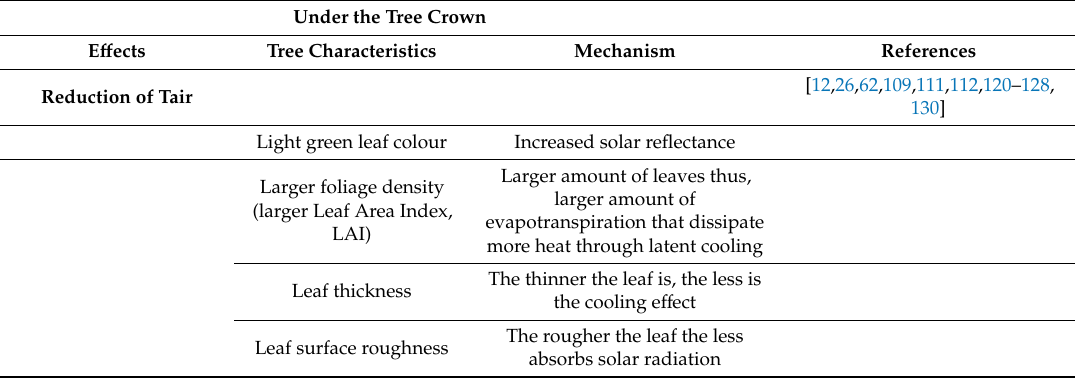
Table 3. E ff ects of vegetation on microclimate during the warmest hours of the day. Under the Tree